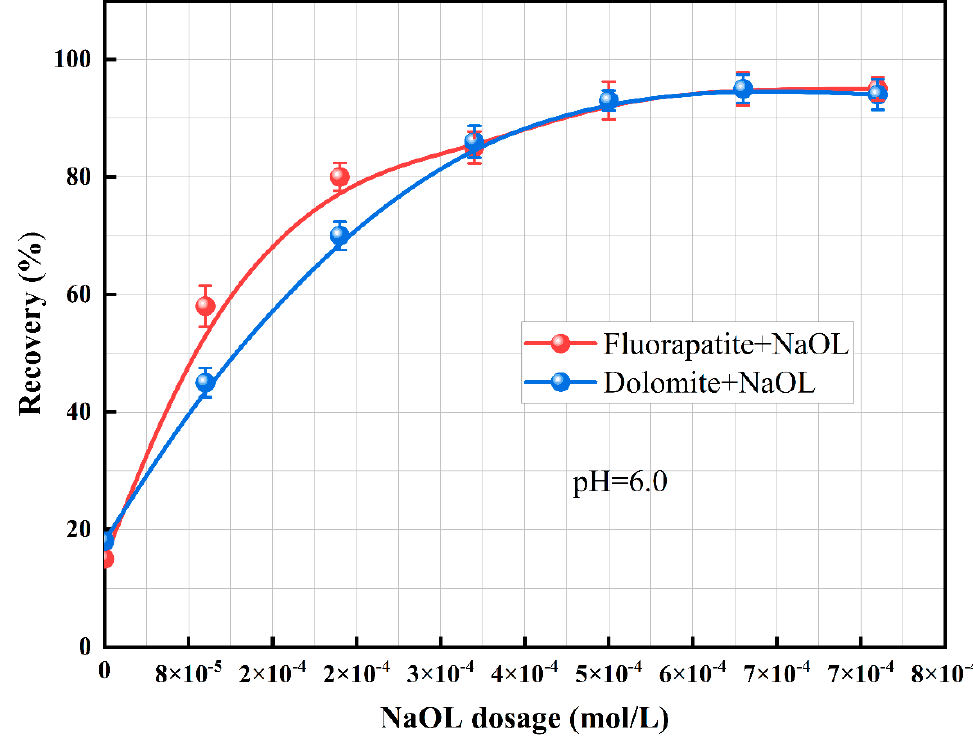
Figure 3. Influence of collector dosage on flotation recovery of fluorapatite and dolomite.